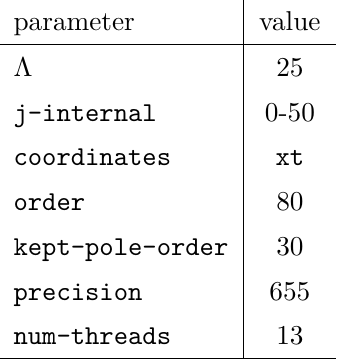
Table 3 : Parameters used in our performance comparison. We use 13 threads because the parallelism is limited by d Λ / 2 e in the current implementation. For the scaling dimension- dependent parameters delta-12 , delta-43 and delta-1-plus-2 we use the values appro- priate for the correlator, assigning some generic scaling dimensions to φ and ψ . block j 12